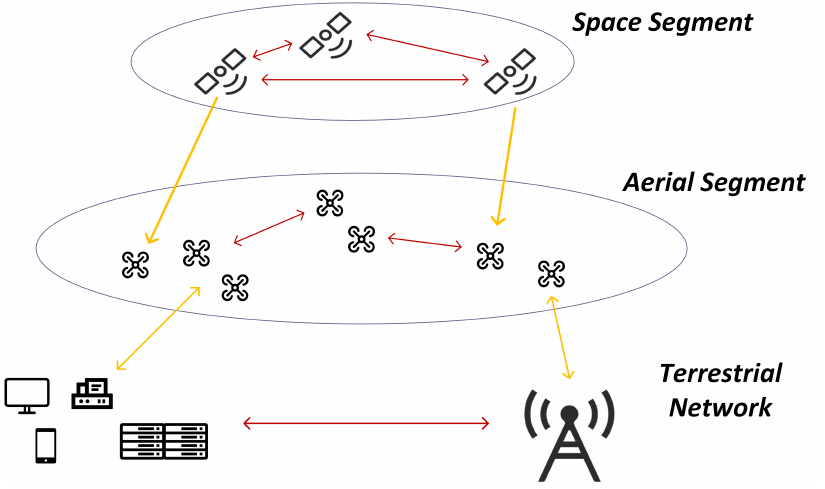
Figure 1. Practical application scenario of SAGIN